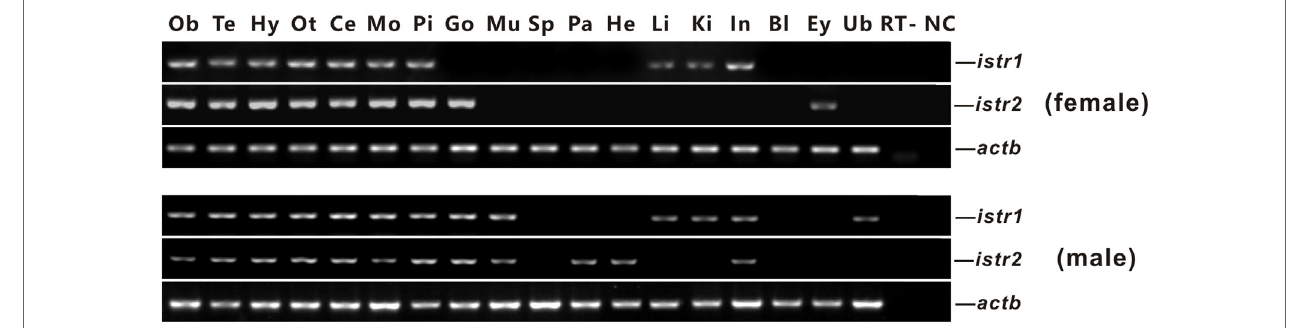
FigUre 3 | Tissue distributions of isotocin ( Ist ) receptor 1 ( istr1 ) and istr2 mRNA in female and male ricefield eels as determined by RT-PCR. Abbreviations: Ob, olfactory bulb; Te, telencephalon; Hy, hypothalamus; Ot, optic tectum-thalamus; Ce, cerebellum; Mo, medulla oblongata; Pi, pituitary; Ov, ovary; Ts, testis; Mu, muscle; Sp, spleen; Pa, pancreas; He, heart; Li, liver; Ki, kidney; In, intestines; Bl, blood; Ey, eye; Ub, bladder; RT, RT minus (no addition of reverse transcriptase); NC, negative control (water used as